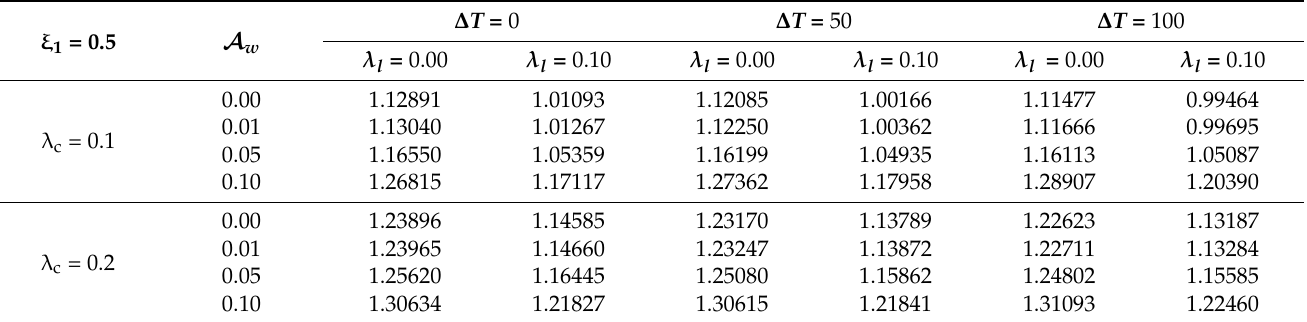
Table 16. Nonlinear dimensionless natural frequencies of porous FG clamped–clamped (C–C) nano- beam for ξ 1 = 0.5 in the case of Third-Order Hamiltonian